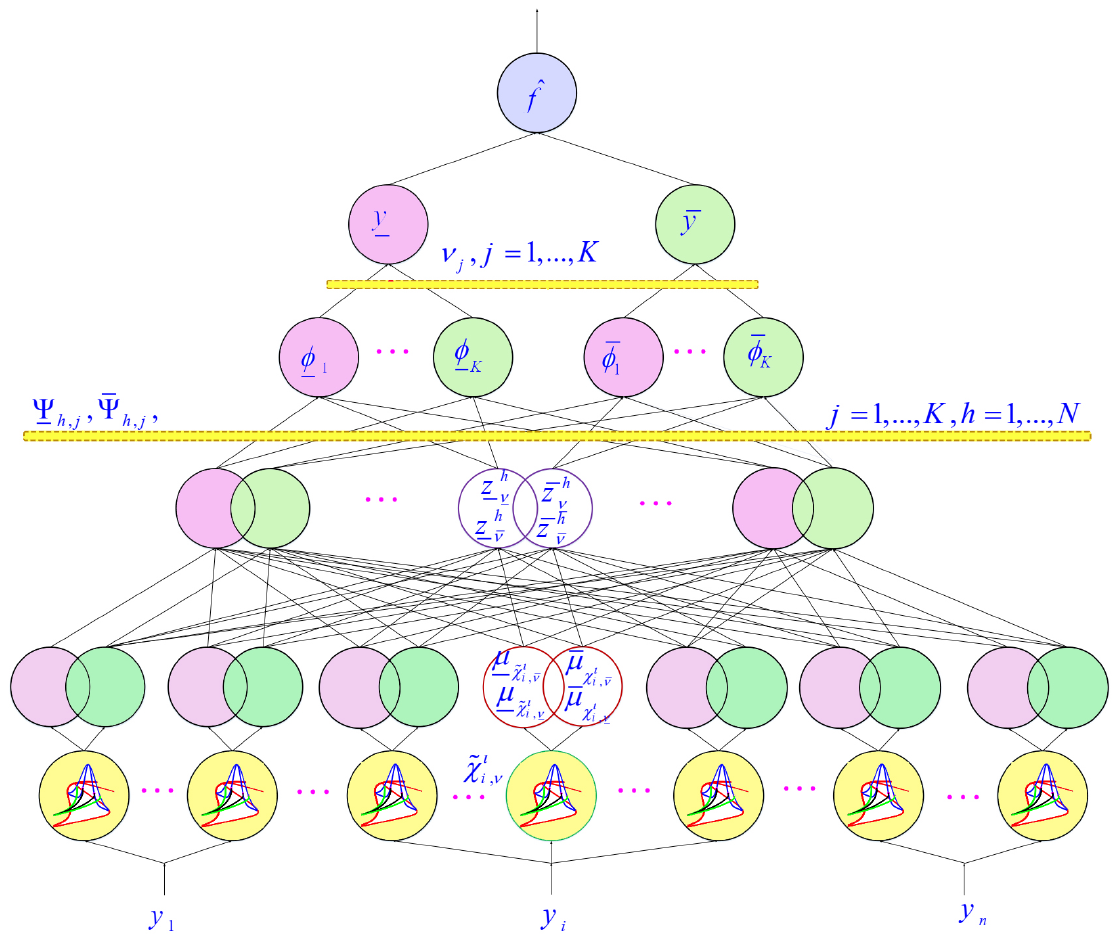
Figure 3. Suggested